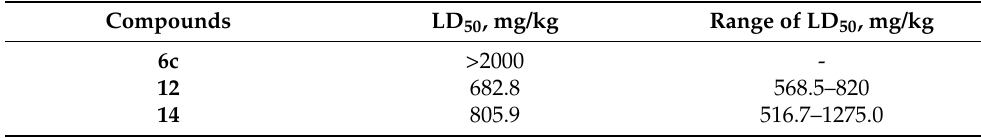
Table 2. In vivo acute toxicity of compounds 6c , 12 and 14 .